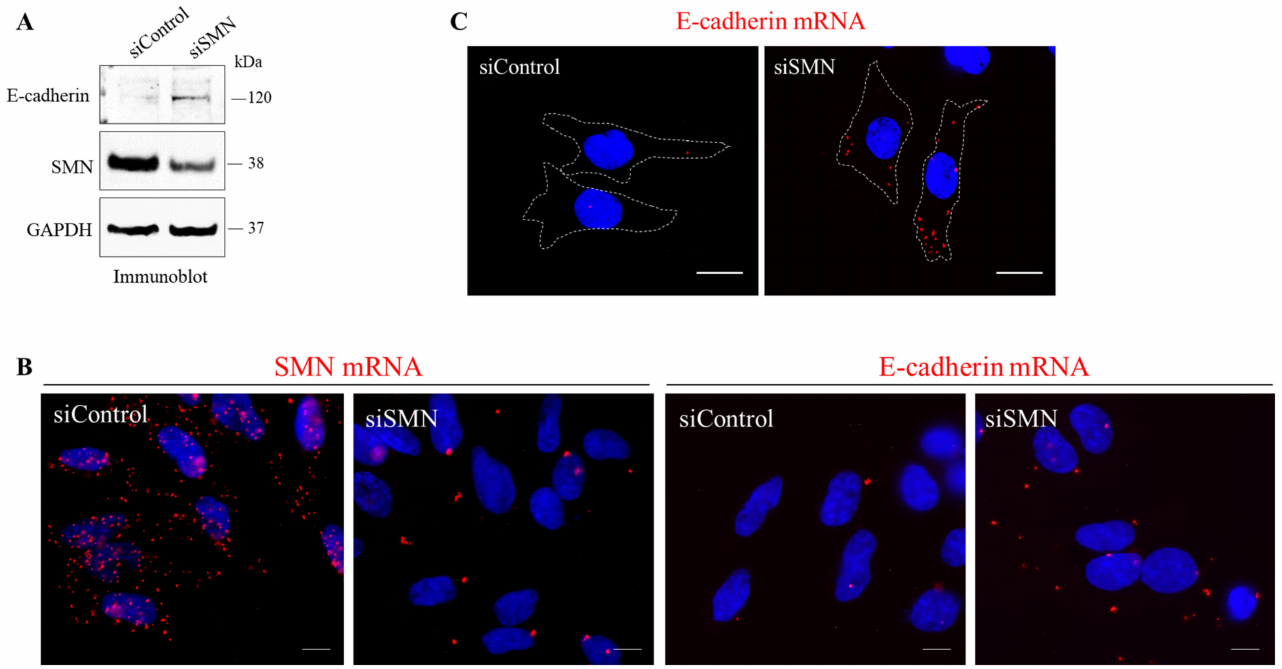
Figure 6. SMN depletion increases E-cadherin expression in HLaC-79 cells. ( A ) Western blot analysis of siControl- and siSMN-transfected HLaC-79 cells. Equal amounts of proteins were checked for E-cadherin and SMN. GAPDH was monitored as control of the protein loading. ( B ) Representative images of SMN mRNA (red dots) or E-cadherin mRNA (red dots) detected by padlock assay in siControl- and siSMN-transfected HLaC-79. Nuclei were labeled with DAPI. Scale bar 10 µ m. ( C ) Representative images visualizing the E-cadherin mRNA (red dots) in siSMN- and siControl- transfected HLaC-79 cells. Outlines of cell surface are marked by a white dotted line. Nuclei were stained with DAPI. Scale bar 10 µ